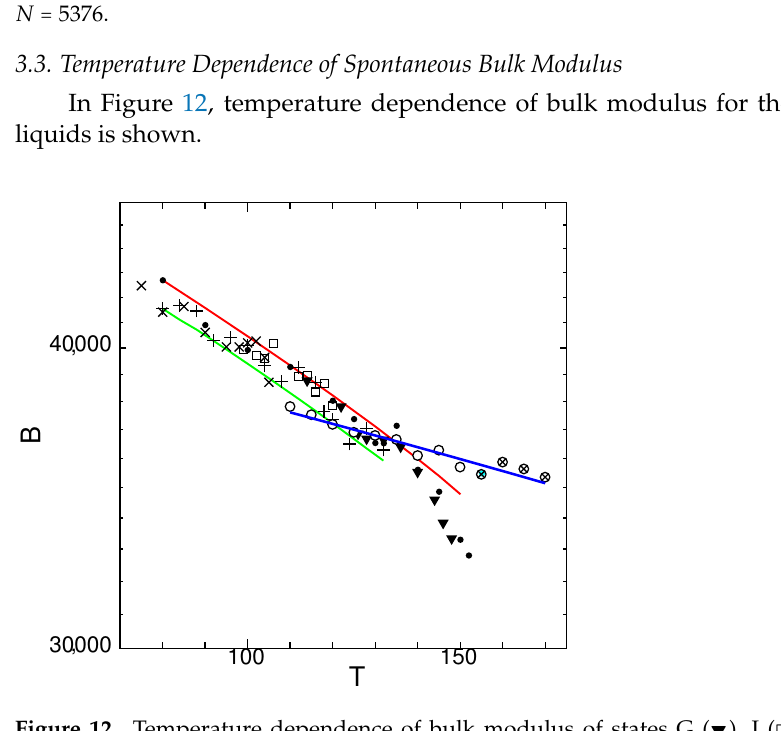
Figure 12. Temperature dependence of bulk modulus of states G ( ▼ ), J ( ◻ ), M ( × ), O ( + ), and crystal ( ● ), with supercooled liquid ( ○ ) and thermodynamic equilibrium liquid ( ⊗ ), for system size N = 5376. Lines are fit to Equation (5) for crystal (red) and state M (green) with reference values B 0 and V 0 at T = 80 of each state. Blue line is a linear fit to data of